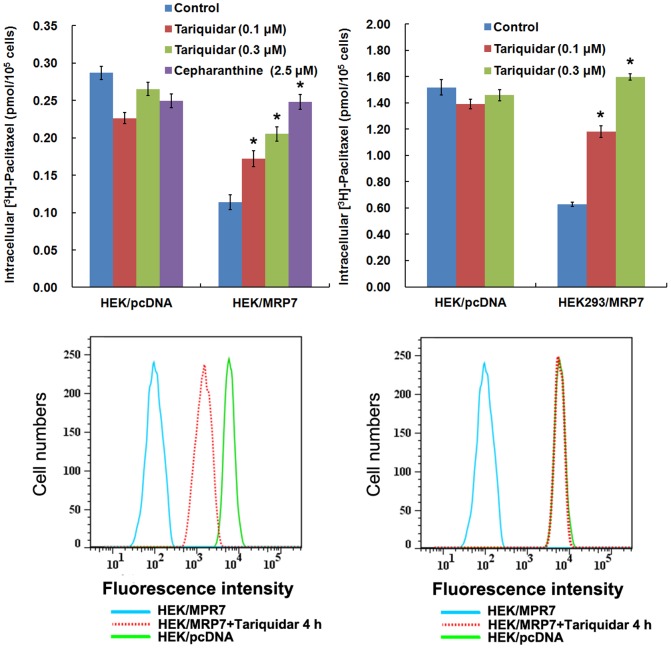
Effect of tariquidar on the accumulation of paclitaxel in HEK/pcDNA and HEK/MRP7 cells.The accumulation of [3H]-paclitaxel was measured after preincubation in the presence or absence of tariquidar at 0.1 µM and 0.3 µM for 2 h (A) or 70 h (B) at 37°C, followed by incubation with 0.1 µM [3H]-paclitaxel with or without of the reversal agents for another 2 h at 37°C. Then, the cells were collected and the intracellular level of [3H]-paclitaxel was detected by scintillation counting. Experiments were done in triplicates, and results were expressed as mean ± SD. *P<0.05, versus the respectively untreated controls. Flow cytemetric detection of the amount of intracellular BODIPY-paclitaxel inside HEK/MRP7 cells after treatment with tariquidar for 4 h and 72 h. The histograms represent the fluorescence signal of intracellular BODIPY-paclitaxel in the presence (dashed line) or absence (shaded histogram) of 4 h (C) or 72 h (D) treatment with 0.3 µM tariquidar.